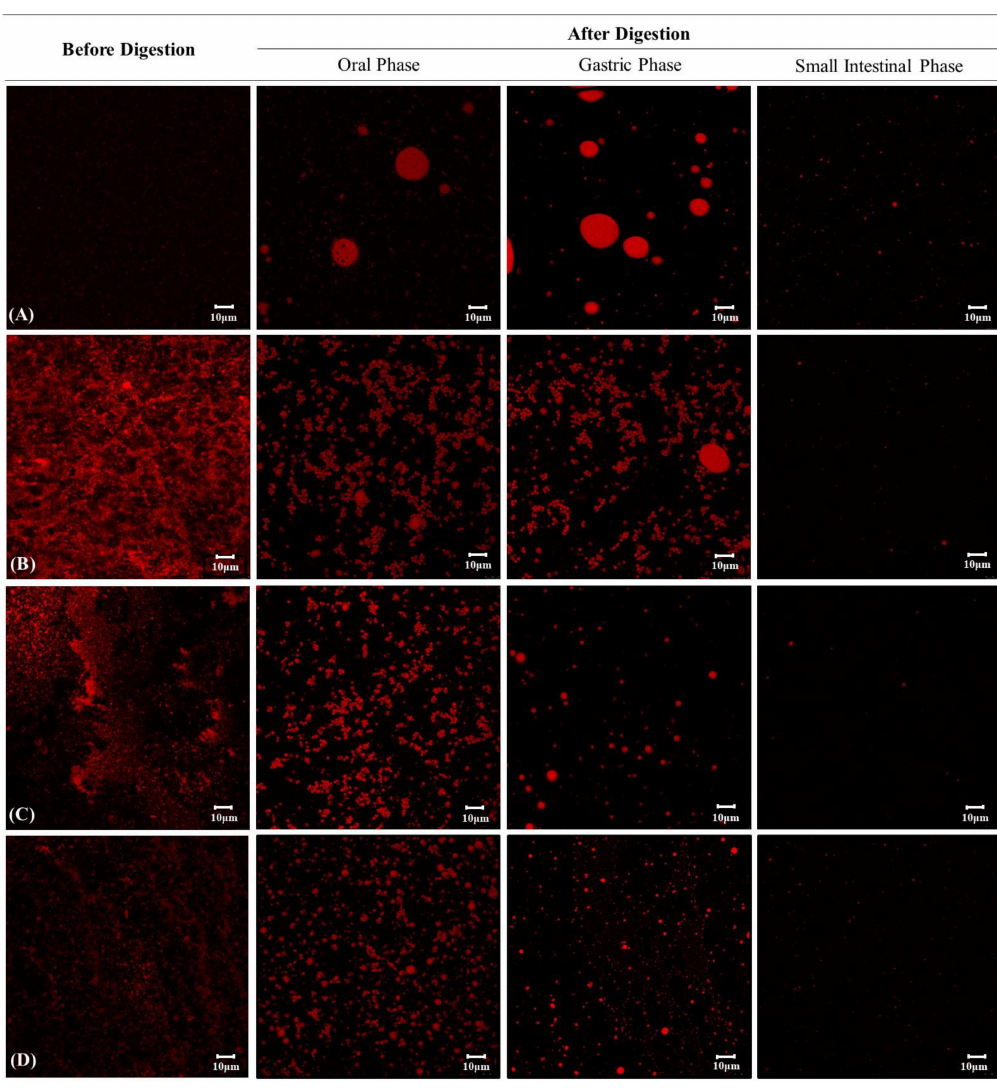
Figure 6. Microstructural changes in ( A ) emulsion (EM), ( B ) native rice starch-based filled hydrogel (RS-FH), ( C ) 4- α - glucanotransferase treated (for 1 h) rice starch-based filled hydrogel (1 GS-FH), and ( D ) 4- α -glucanotransferase treated (for 96 h) rice starch-based filled hydrogel (96 GS-FH) determined using confocal microscopy during in vitro digestion. Photographic images indicate the appearance of the sample before digestion and after digestion at the stages of the oral, stomach and small intestine phases. The red parts represent the lipid and the scale bar represents the length of 10 µ